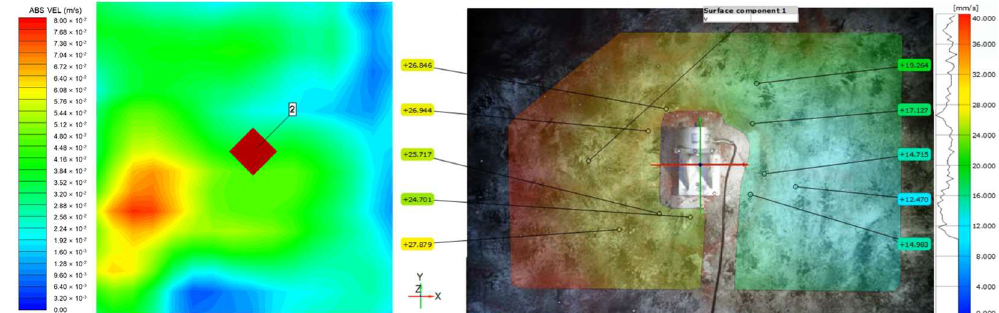
Figure 13. Comparison of numerical analysis result ( left ) and DIC result ( right ).